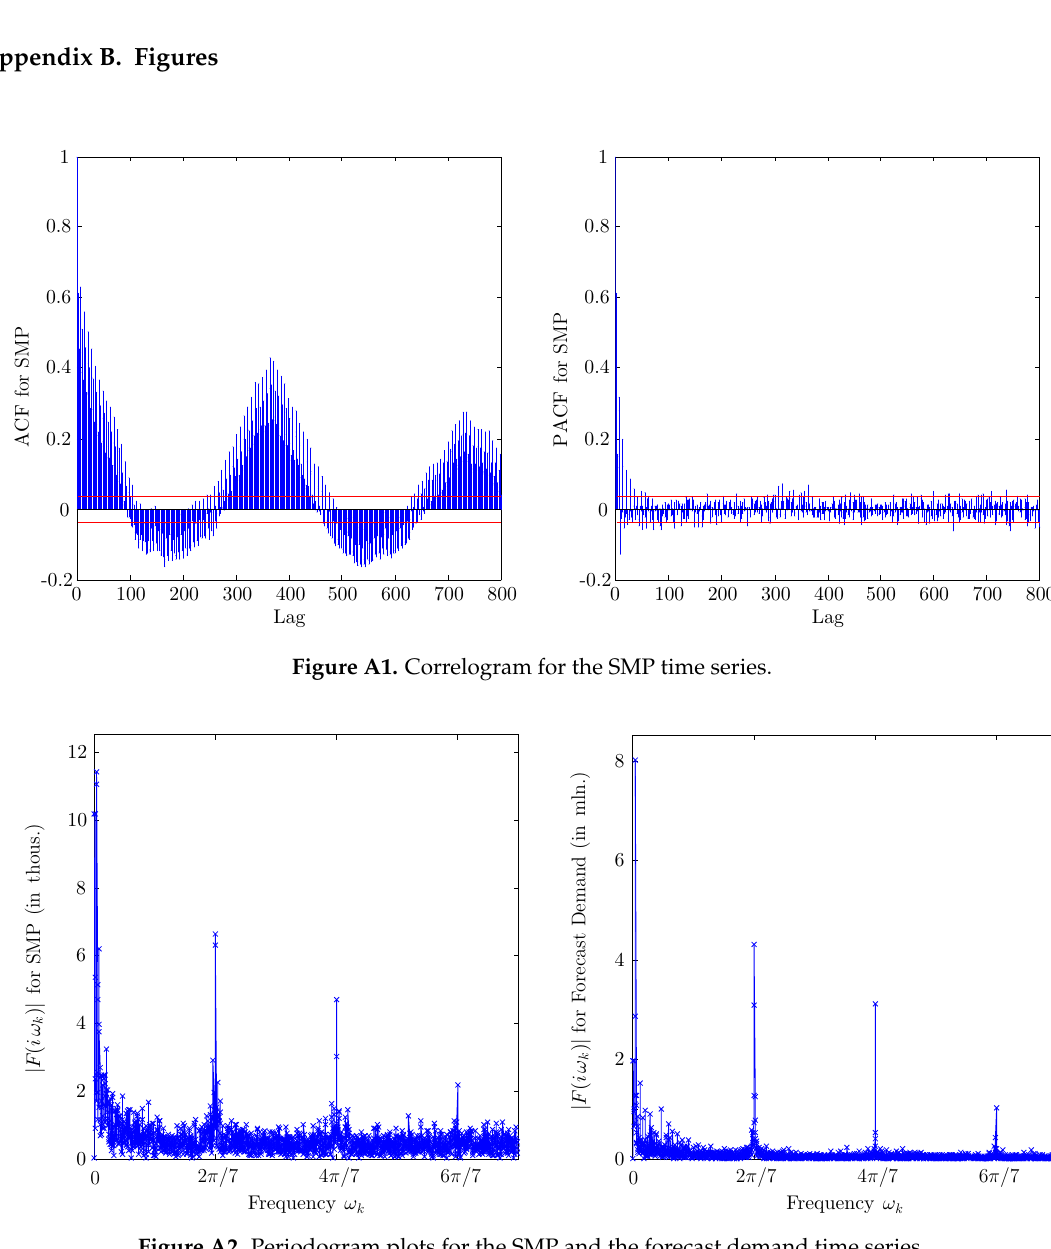
Figure A2. Periodogram plots for the SMP and the forecast demand time